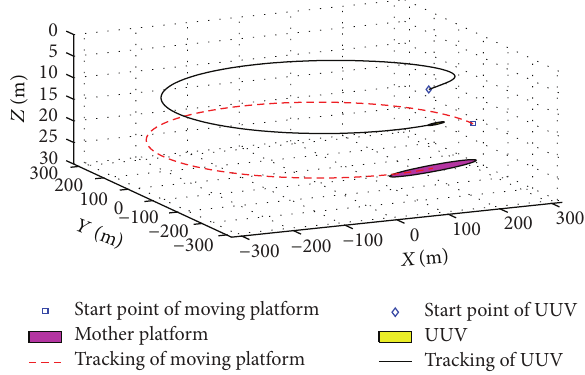
Figure 12: UUV tracking moving platform simulation in case 2: 𝑡 = 700